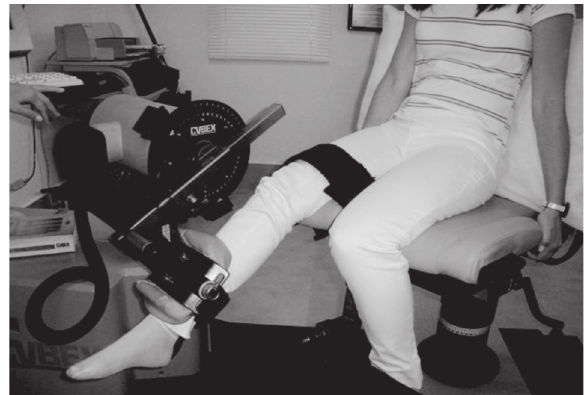
Figura 1 - Posicionamento do voluntário na cadeira do dina- mômetro